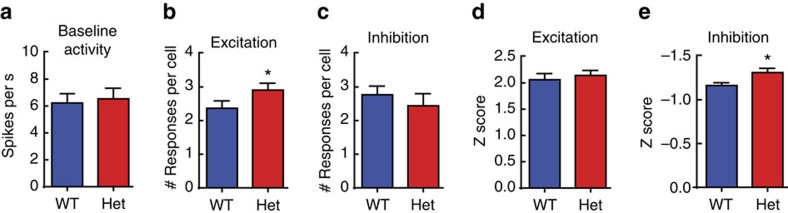
Auditory cortex activity is grossly similar in NaiveHet and NaiveWT.(a) Baseline spontaneous activity was not different between NaiveWT and NaiveHet (WT: n=99 cells, 11 mice; Het: n=87 cells, 13 mice; Mann–Whitney, P=0.70). (b,c) NaiveHet neurons were excited by a small but significantly greater number of stimuli (b; WT: n=56 cells, 11 mice; Het: n=66 cells, 13 mice; Mann-Whitney, *P=0.047), but inhibited by a similar number of stimuli compared with NaiveWT (c; WT: n=47 cells, 11 mice; Het: n=24 cells, 13 mice; Mann–Whitney, P=0.33). (d,e) Response strength, measured as a z score, was not significantly different between NaiveWT and NaiveHet, for excitation (d) but was significantly increased in NaiveHet for inhibition (e) (Excitation: WT: n=136 responses, 56 cells, 11 mice; Het: n=192 responses, 66 cells, 13 mice; Mann-Whitney, P=0.43; Inhibition: WT: n=133 responses, 47 cells, 11 mice; Het: n=59 responses, 24 cells, 13 mice; Mann–Whitney, *P=0.0054). (a–e) Bar graphs represent mean±s.e.m.